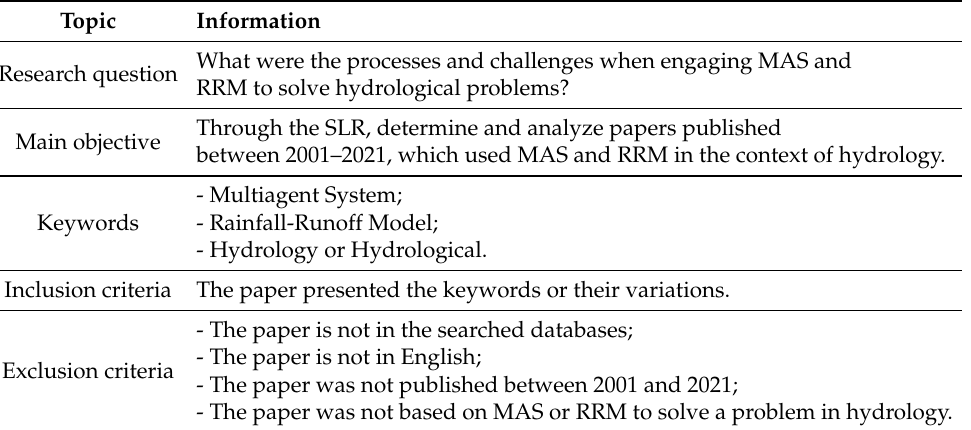
Table 2. SLR protocol: main